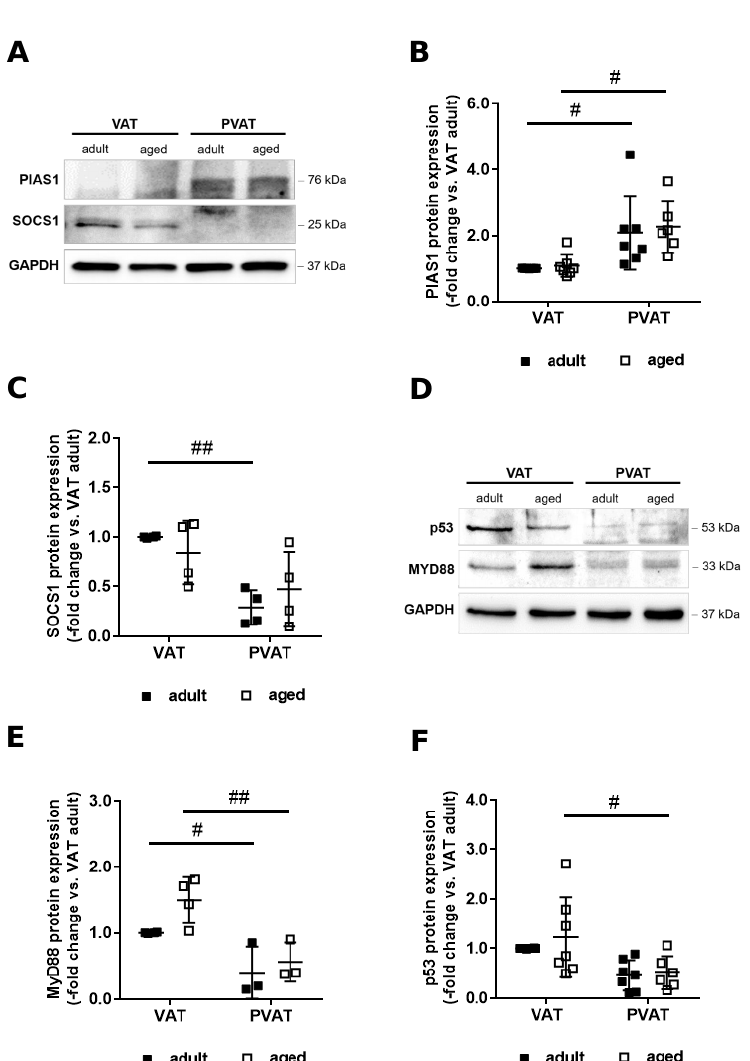
Figure 5. Perivascular adipose tissue expression of negative regulators of STAT1 and NF κ B. ( A , B ) Western blot analysis of protein inhibitor of activated STAT-1 (PIAS1), ( A , C ) suppressor of cytokine signaling-1 (SOCS1), ( D , E ) myeloid di ff erentiation primary response-88 (MyD88), and ( D , F ) tumor suppressor p53 (p53) in visceral (VAT) and perivascular (PVAT) adipose tissue of adult ( n = 3–8) and middle-aged ( n = 3–8) mice. Results were normalized to GAPDH protein levels and are expressed as -fold change vs. findings obtained in VAT of adult mice. Individual data points and the mean ± SD are shown. # p < 0.05 and ## p < 0.01 vs. VAT (as determined using two-way ANOVA). Representative Western blot membranes are shown in panels ( A , D